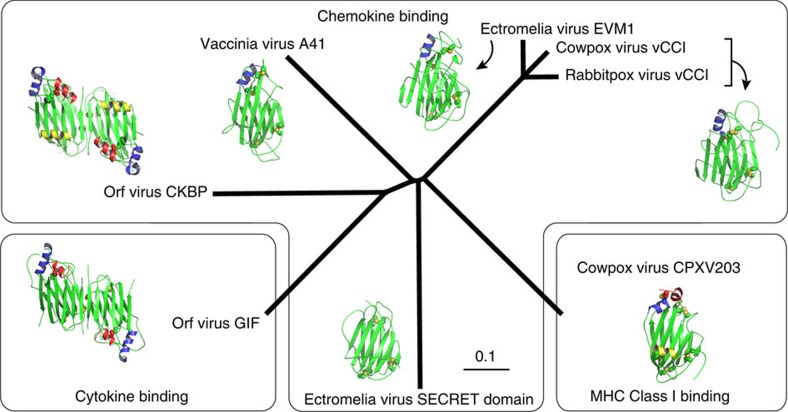
Phylogenetic tree of members of the Poxviral Immune Evasion (PIE) superfamily with known structures.The phylogenetic tree, based on the alignment presented in Supplementary Fig. 1, is generated by ClustalW2 (ref. 78) and visualized by Geneious 4.8.5 (ref. 79). The scale bar represents the number of substitutions per site. Representative structures (Orf virus GIF: 5D28, Orf virus CKBP: 4ZK9 , Vaccinia virus A41: 2VGA, Rabbitpox virus vCCI: 2FFK, ectromelia virus SECRET domain: 3ON9 , Rabbitpox virus CPXV203: 4HKJ) displaying a variation of the PIE superfamily β-sandwich fold are shown for each branch.